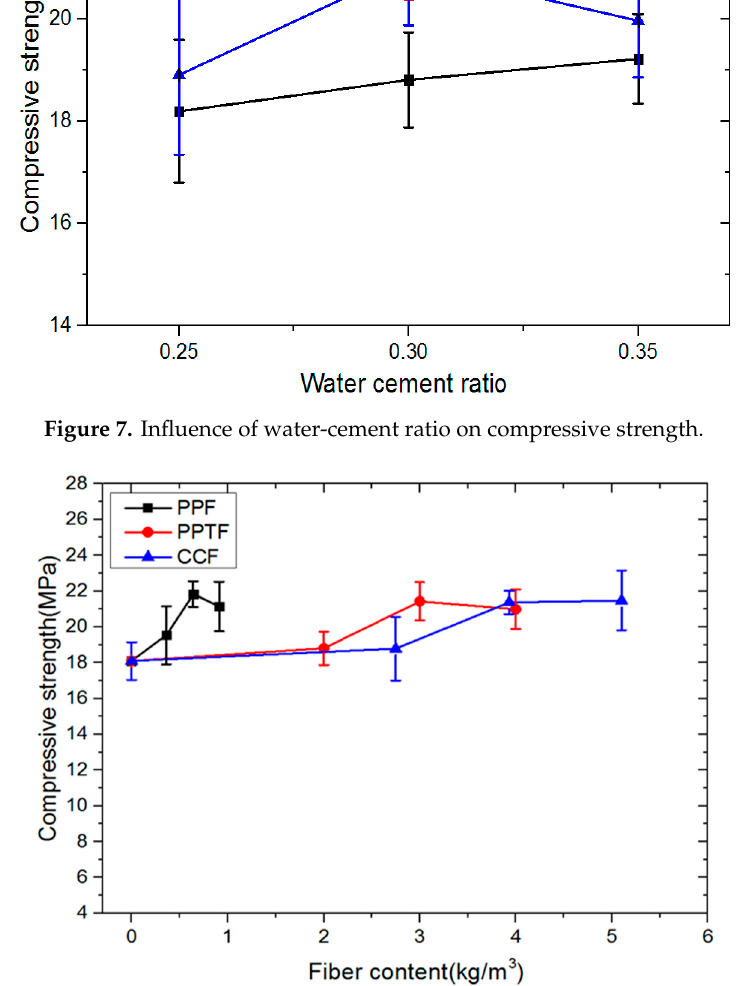
Figure 7. Influence of water-cement ratio on compressive strength.